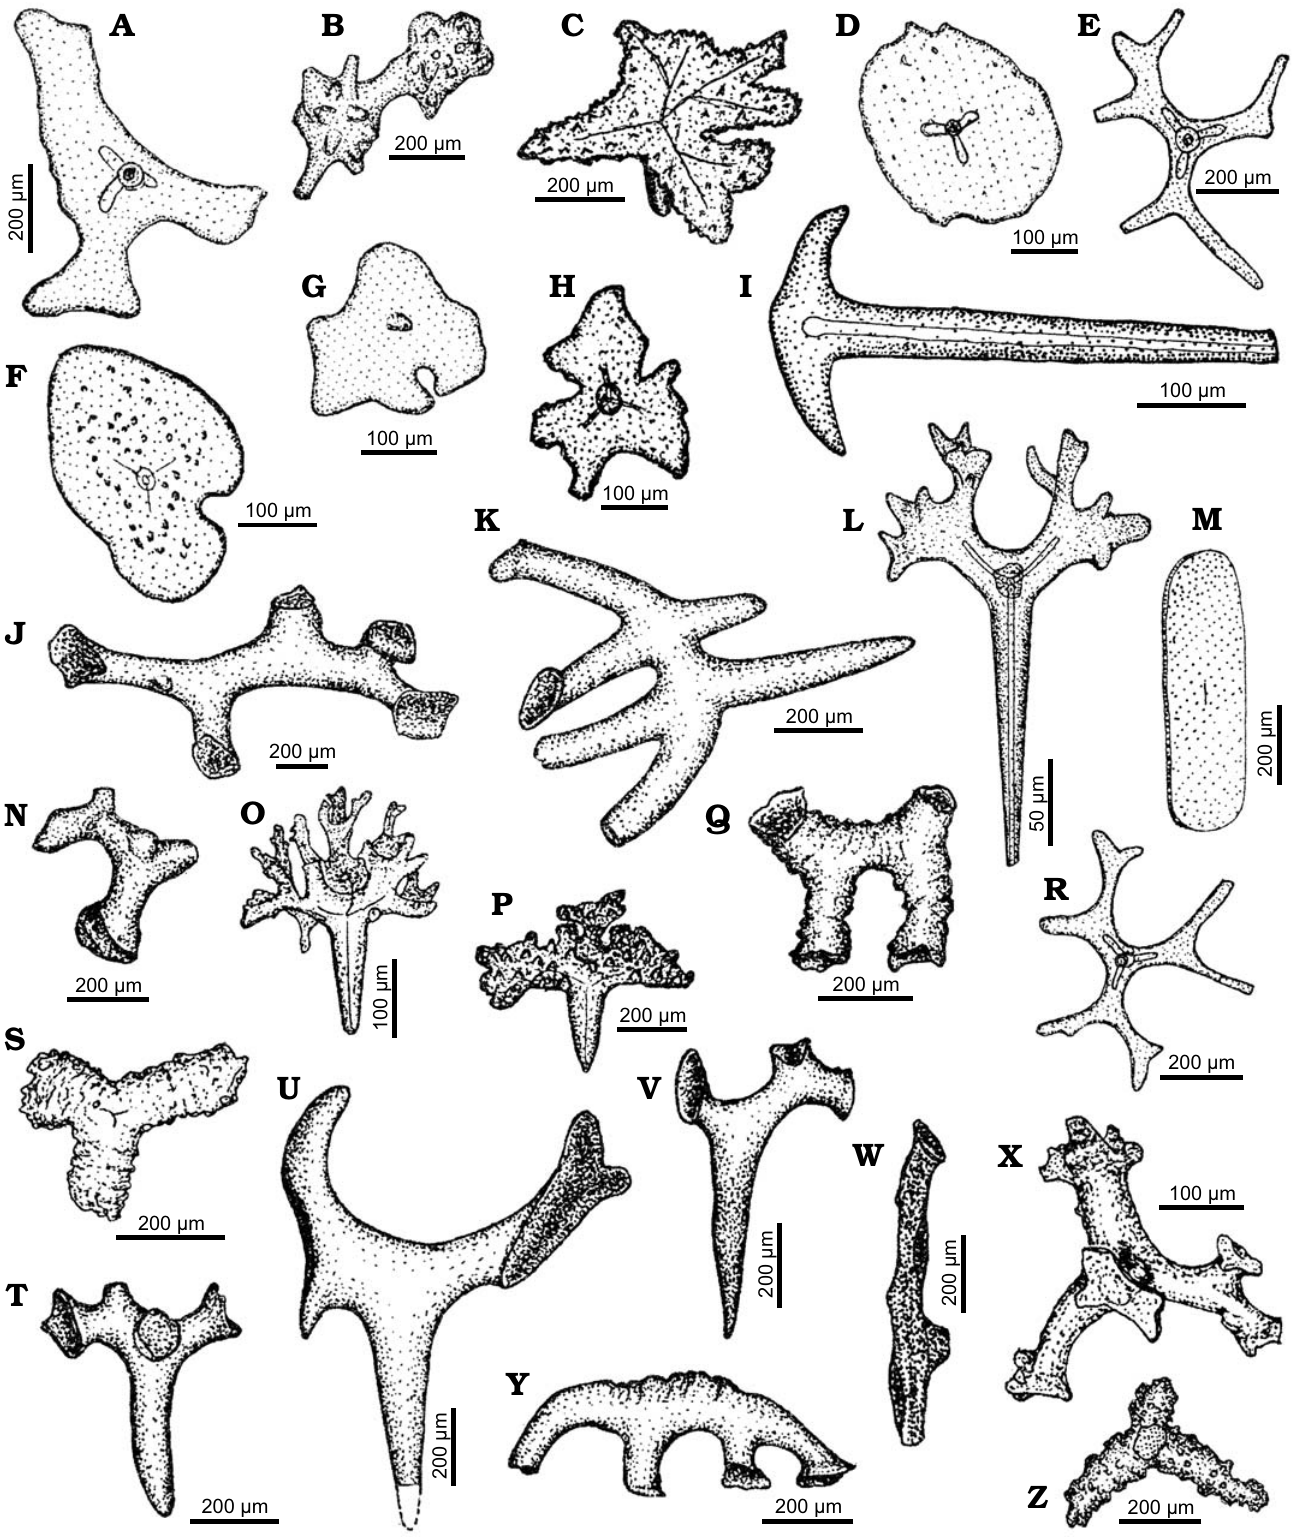
Fig. 9. Spicule morphotypes from south-central Ukraine (A–V, X–Z) and Lithuania (W); Markovka, middle Eocene (A, D, E), Verhnee, lower Eocene (B, Z), Glâdov Âr, Upper Creatceous (C, J, K, P, Q, T, U, V, Y), Pes č anoe, upper Eocene (F, O), Kiselevka, middle Eocene (G, L, R), Markovka, upper Eocene (H, X), Nikol’skoe, upper Eocene (I, S), Lipcy, middle Eocene (M), Monastyrek, lower Eocene (N), and Neravai borehole, Paleocene (W). A , C , E , H , L , O , P , R . Phyllotriaenes. B . Sphaeroclone. D , F , G . Discotriaenes. I . Anchorate spicule. J , K , N , Q , S – W , Y . Megaclones. M . Siliceous plate. X , Z . Tetracrepid desmas. After Ivanik (2003);